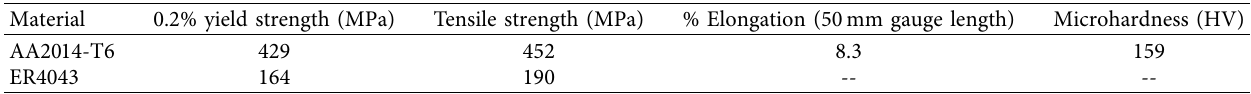
Table 2: Mechanical properties of the AA2014-T6 aluminum alloy and ER4043 filler wire.